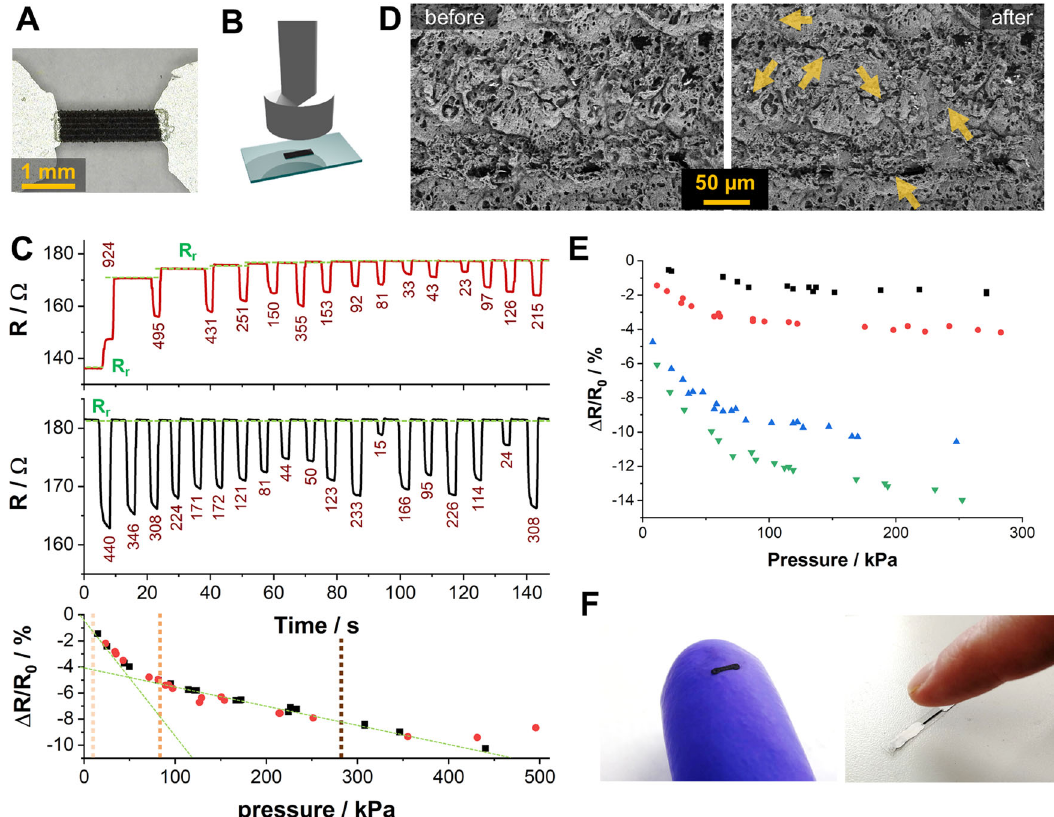
Fig. 3 Performance of fl exible LP-C strips as pressure sensors. A Photograph of an LP-C pressure sensor on fl exible PET used for quantitative experiments. B Experimental setup for the pressure sensing experiments. C Training and performance of the LP-C. Upper panel: Initial response of the resistance upon application of different pressures (Training). Center panel: Response of the resistance upon application of different pressures after training/stabilization (Operation). Lower panel: Change in resistance in dependence of the applied pressure, the dashed lines indicate a quanti fi cation of fi nger pressure (smart phone touch (light), pressing door bell (medium), maximum fi nger pressure (dark). D Scanning electron micrographs of the LP-C pressure sensor before and after applying a maximum pressure of 500 kPa. E Quantitative response of LP-C sensors with different thickness or laser settings. F Photographs of LP-C pressure sensors directly printed onto nitrile gloves or (Fig. 2E). Two further exemplary bending patterns are given in Fig. 2F. The two bending directions and the extent of bending can be clearly differentiated. Such patterns represent, for instance, fi nger motions in the positive mode as shown in Fig. 2G. The response is systematically dependent on the fi lm thickness.